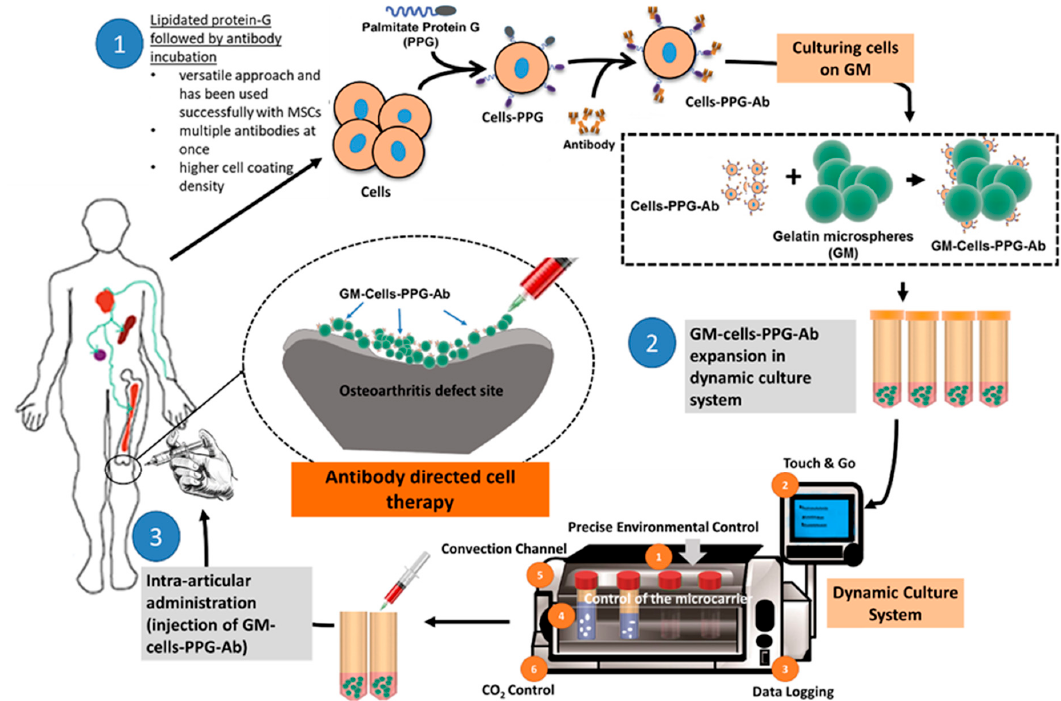
Figure 4. A conceptual diagram of the gelatin microsphere, together with antibody-coated cells (MSCs or chondrocytes), which can thus form an in vivo engineered tissue that will firmly bind to the injured site of the cartilage.